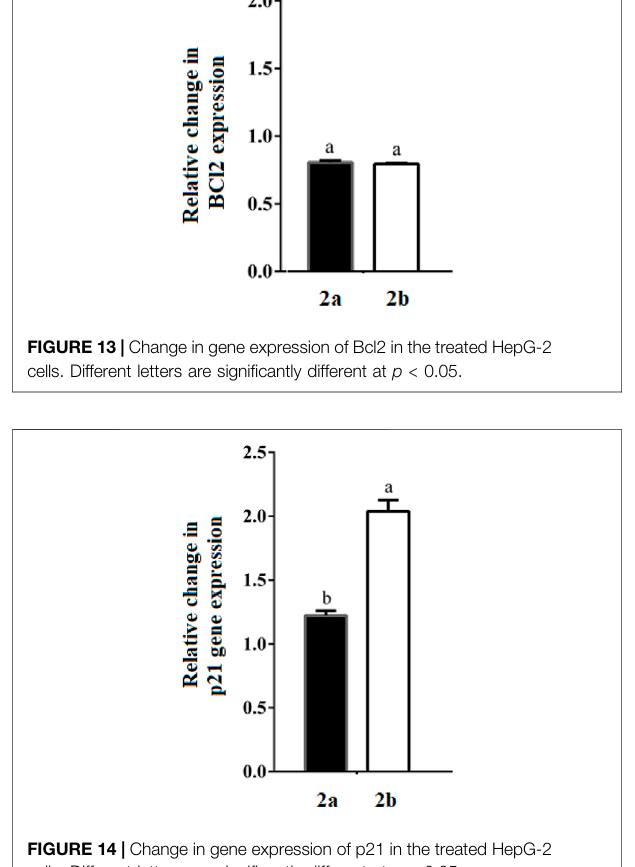
Frontiers in Chemistry |